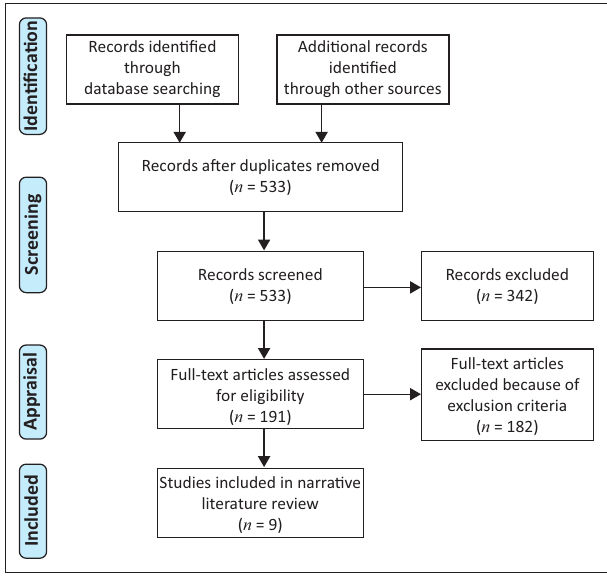
FIGURE 2: Flow chart of the search strategy (adapted from the 2009 PRISMA flow